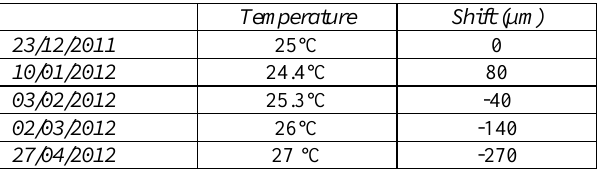
Table 2 : Results of the focusing campaigns